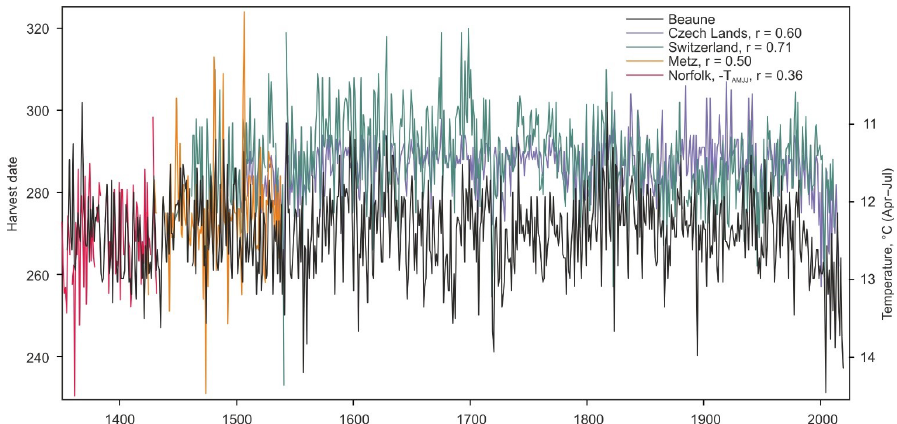
Figure 7. Comparison of times series of GHDs from Beaune (this work), Czech lands (Možný et al., 2016), Switzerland (Wetter and Pfister, 2013), and Metz (Litzenburger, 2015), as well as temperature reconstructions for Norfolk (Pribyl et al., 2012; right scale, inverted). The number indicates the correlation between the series prior to